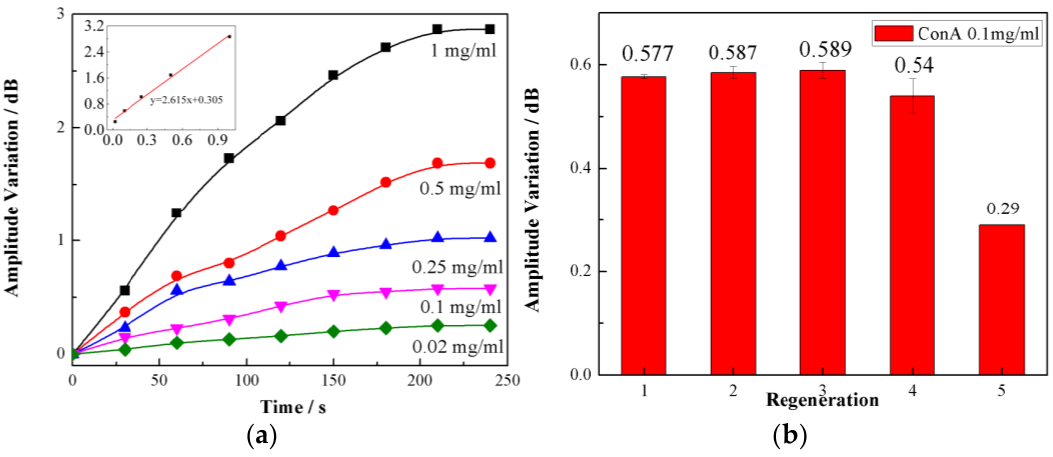
Figure 5. ( a ) The different concentrations of concanavalin A (Con A). The variation was 0.252 dB, 0.573 dB, 1.020 dB, 1.689 dB, and 2.867 dB when the concentration was 0.02 mg/mL, 0.1 mg/mL, 0.25 mg/mL, 0.5 mg/mL, and 1 mg/mL, respectively. ( b ) The regeneration of the developed TFBG-based sensor. The relative standard deviations were 0.69%, 2.44%, 2.79%, 5.76%, and 49.39%, respectively.